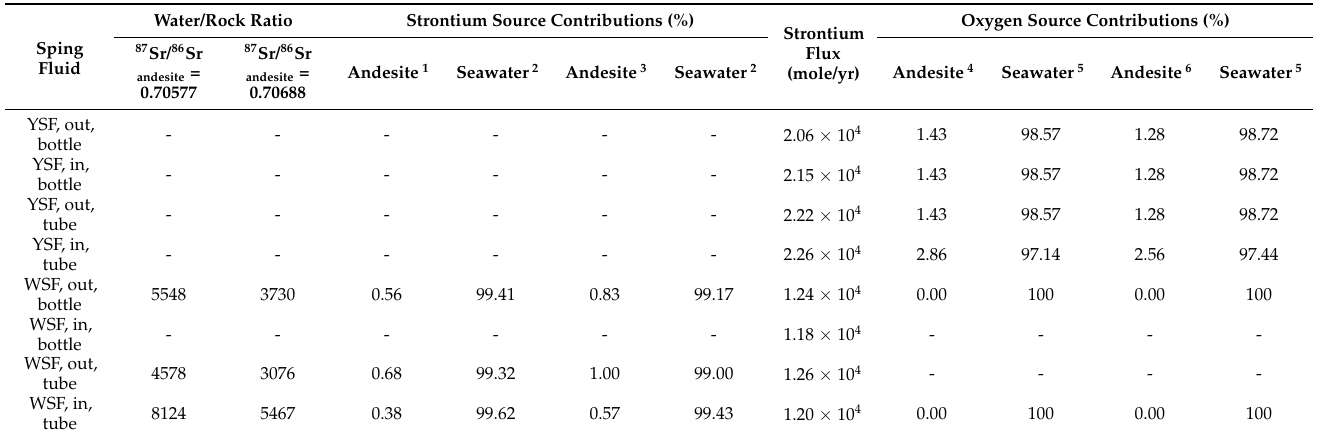
Table 3. Calculated water/rock ratios, Sr and O source contributions and Sr fluxes in the Kueishantao hydrothermal